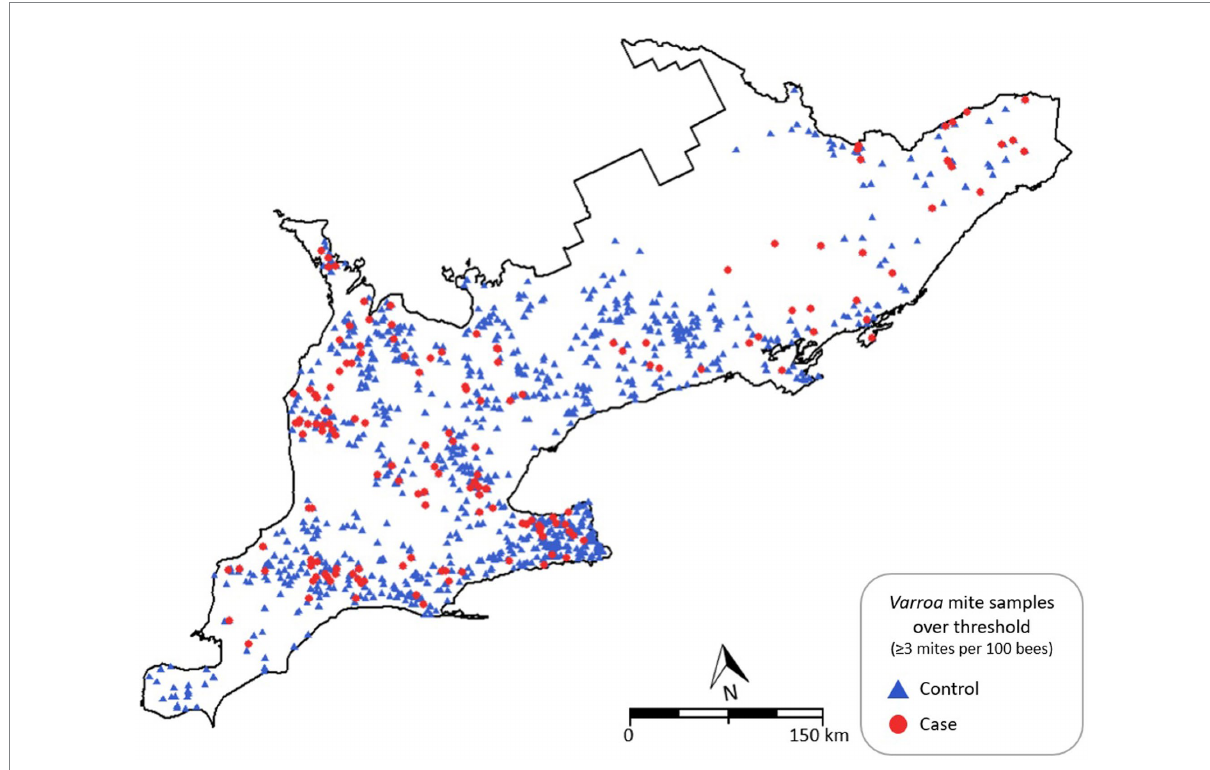
FIGURE 1 Point map of Southern Ontario indicating Varroa destructor counts above threshold ( ≥ 3 mites per 100 bees) as cases in red circles and controls in blue triangles,